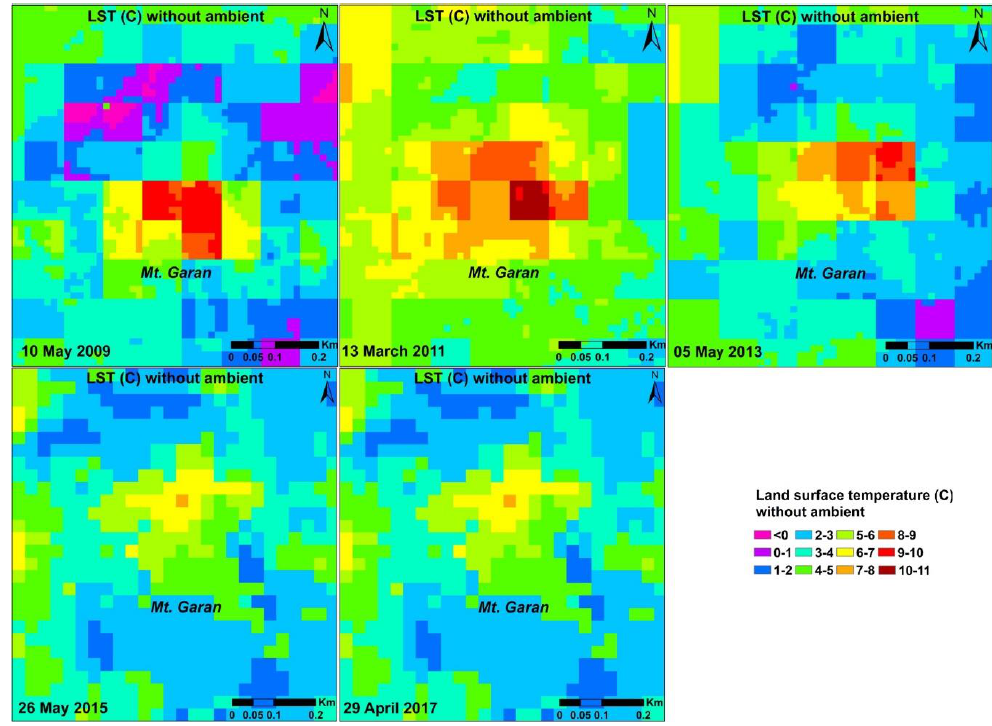
Figure 7. Land surface temperature without ambient temperature of the Mt. Garan fumaroles area using a split-window algorithm derived from nighttime ASTER infrared data for 2009, 2011, and 2013 ( top row ), and derived from nighttime Landsat 8 TIRS data for 2015 and 2017 ( bottom row ).